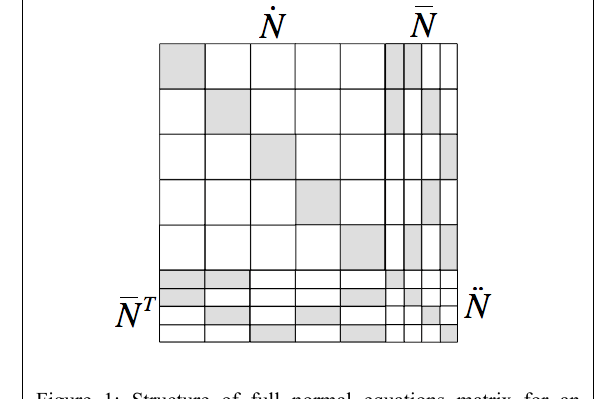
Figure 1: Structure of full normal equations matrix for an example network with five images and four points. Gray blocks are non-zero, white are